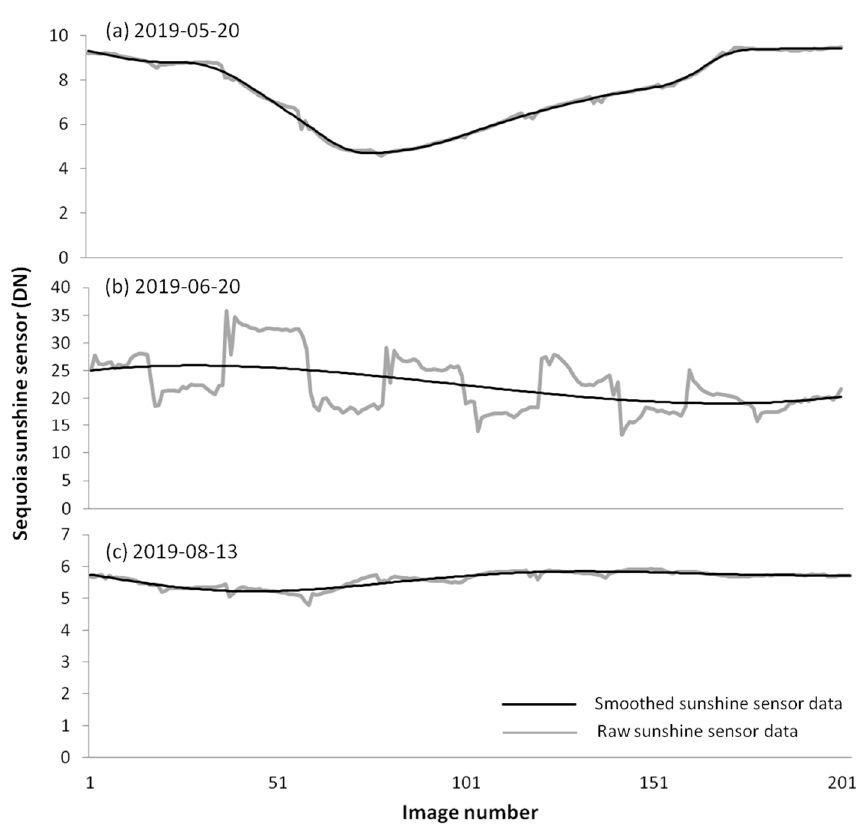
Figure 4. Raw sunshine sensor data (gray) and smoothed sunshine sensor data (black) for the flights on 20 May 2019 ( a ), 20 June 2019 ( b ), and 13 August 2019 ( c ).